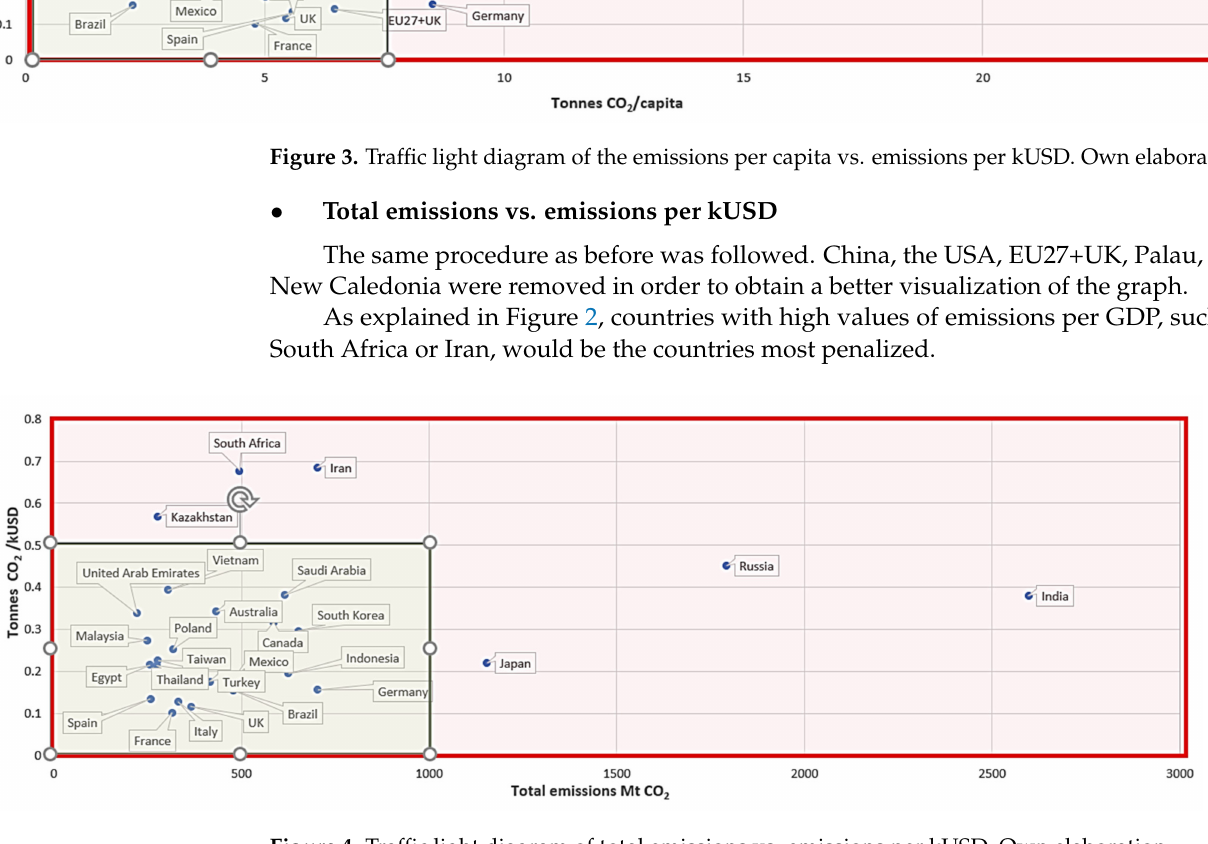
Figure 4. Traffic light diagram of total emissions vs. emissions per kUSD. Own